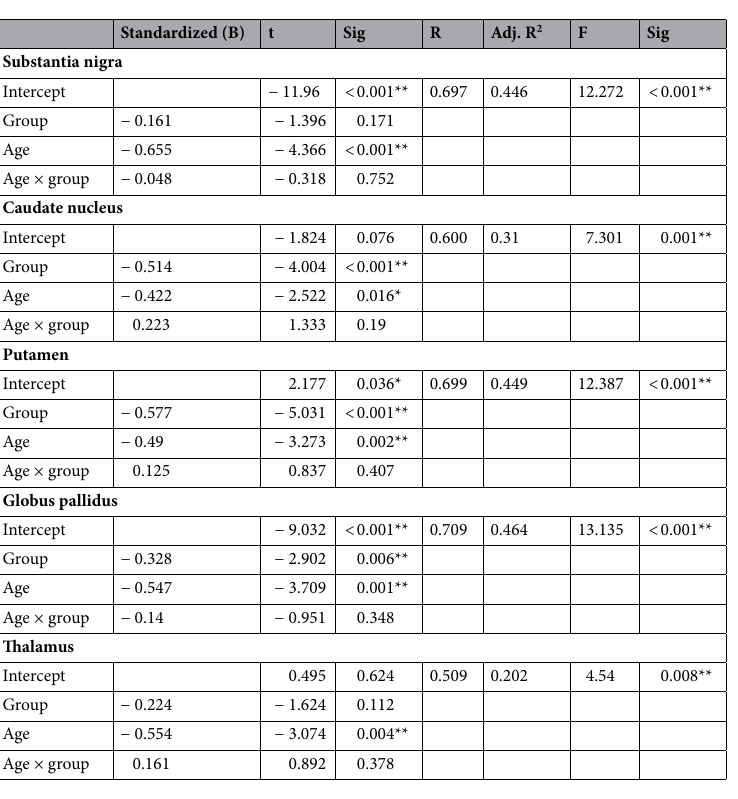
Table 3. Multiple linear regression for contrast ratio of deep gray matter with age and group. Group was calculated as Dummy variable: control = 0, RTT = 1. * p < 0.05, ** p < 0.01.